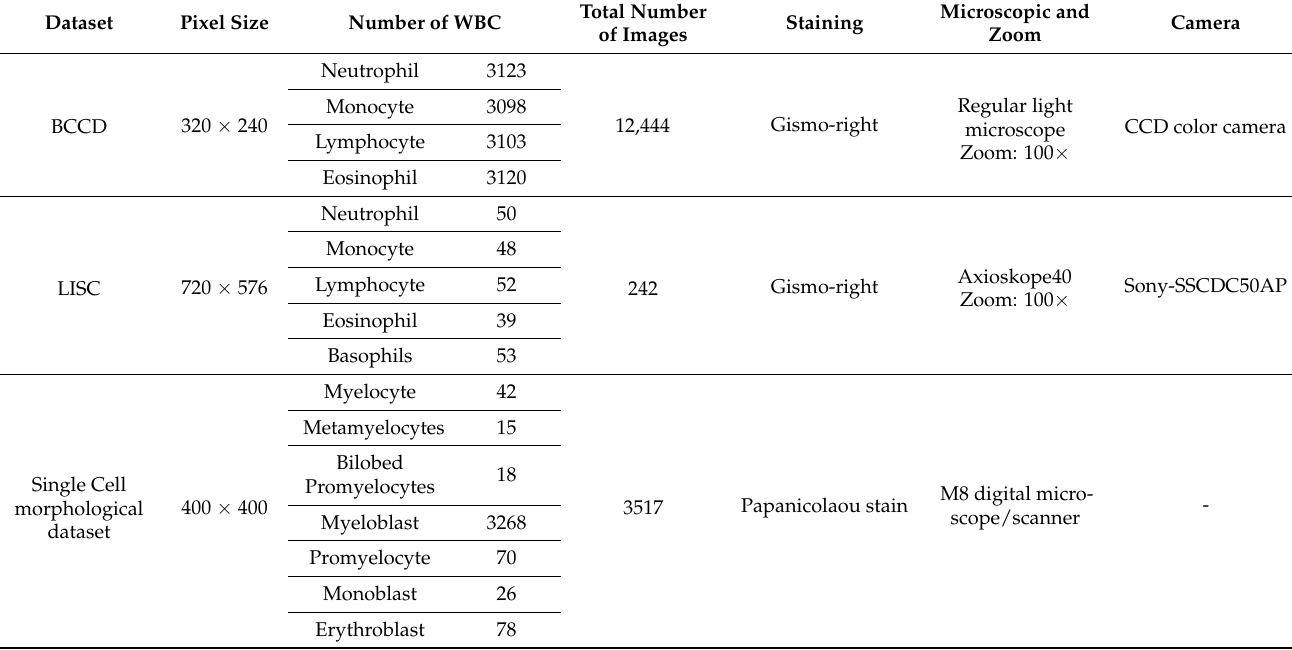
Table 2. Properties of three